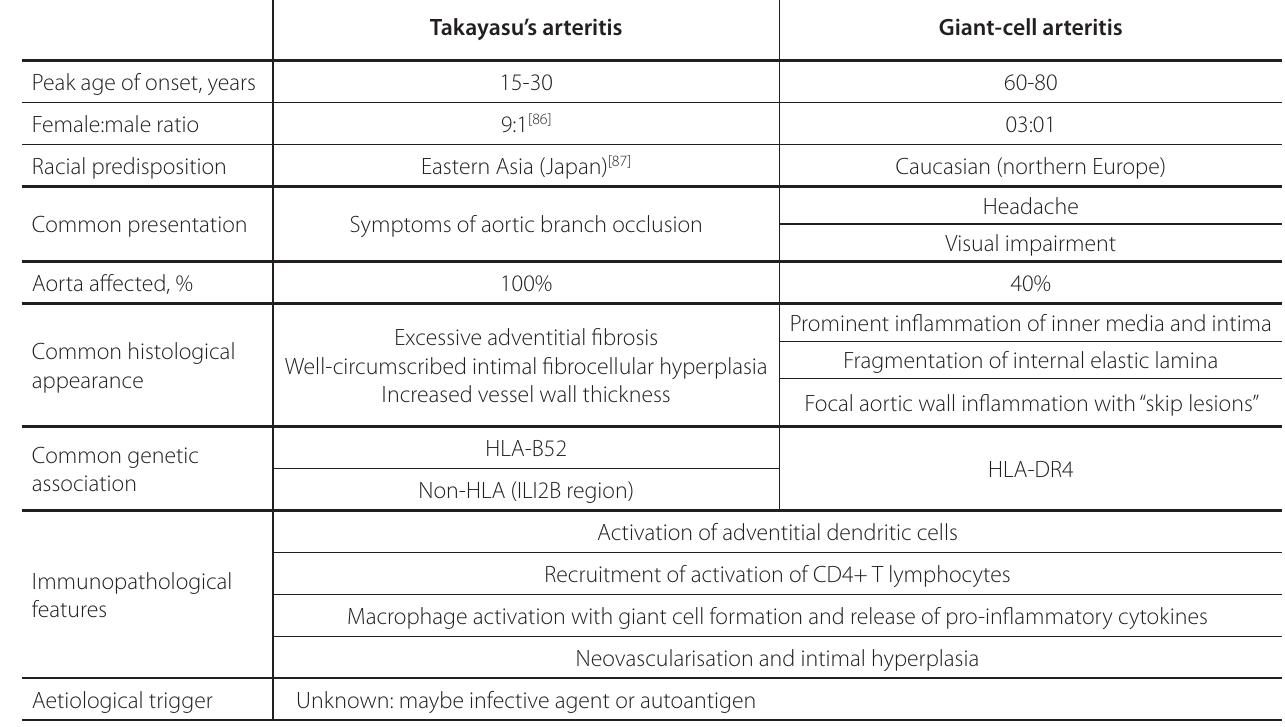
Table 2 . Summary table highlighting the differences between Takayasu’s arteritis and giant-cell